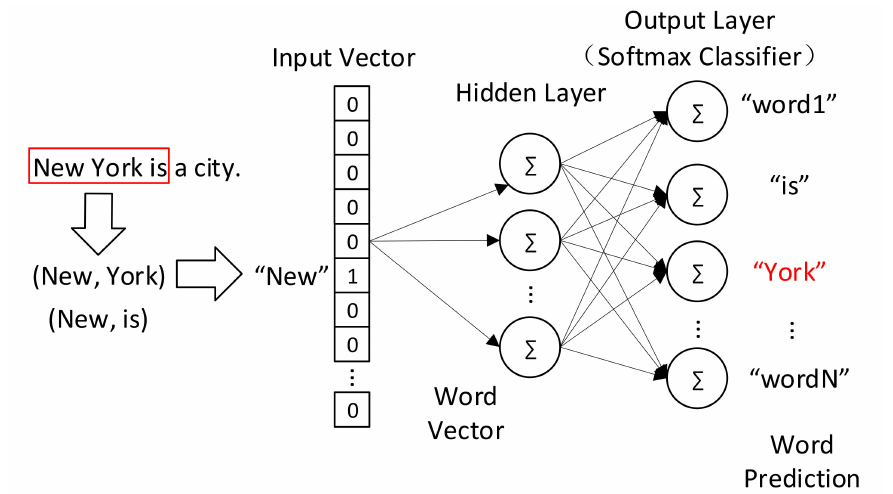
Figure 3. A skip-gram model.